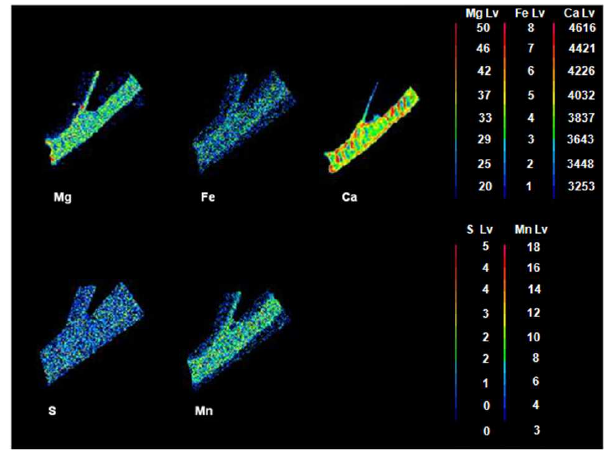
Fig. 5. EMP elemental mapping of a section from an Uvigerina peregrina specimen from 640m water depth (M77-1-565/MUC-60) on an exposed section of the foraminiferal test treated with an ox- idative cleaning procedure. Distribution of Mg, Fe, Mn, S and Ca in the foraminiferal test. All intensity values are expressed in counts per second (cps) as shown in the color bars. Note that no contami- nant phases are visible in the Fe distribution.